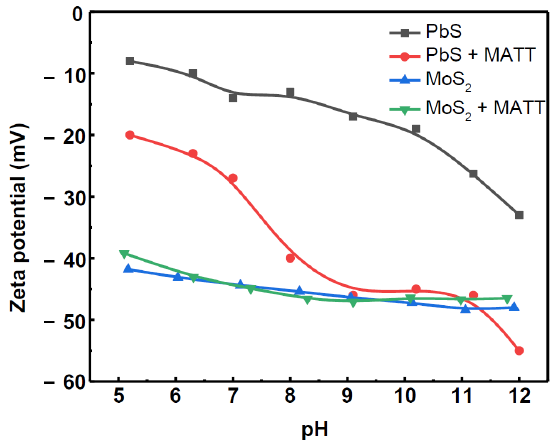
Figure 6. The zeta potentials of galena and molybdenite as a function of pH . After the treatment of MATT, zeta potential became more negative, which may be ascribed to the carboxyl acid (-COO-) and thiol (-SH) functional groups from the MATT molecule. Thiol group could be adsorbed on the metal site of galena surface, while car- boxyl acid group (-COO-) formed negative molecular film, resulting in the more negative zeta potential than pure galena. The zeta potential of MATT-treated galena reached to a plateau at pH of about 9.0, indicating a maximum adsorption of MATT occurred within the pH range of 9.0–11.0. It should be noted that 1,3,4-thiadiazole group contributed to its adsorption onto the PbS surface. However, it also could be observed from Figure 6 that MATT barely influenced the zeta potentials of molybdenite, which indicated that MATT was weakly adsorbed on mo- lybdenite surface in the pH range of 5.0–12.0. These results could explain well that the floatability of molybdenite was almost not affected by the addition of MATT depressant as shown in Figures 3 and 4.